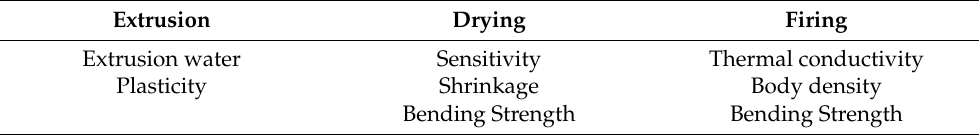
Table 18. Variations of mechanical and physical properties on three (3)